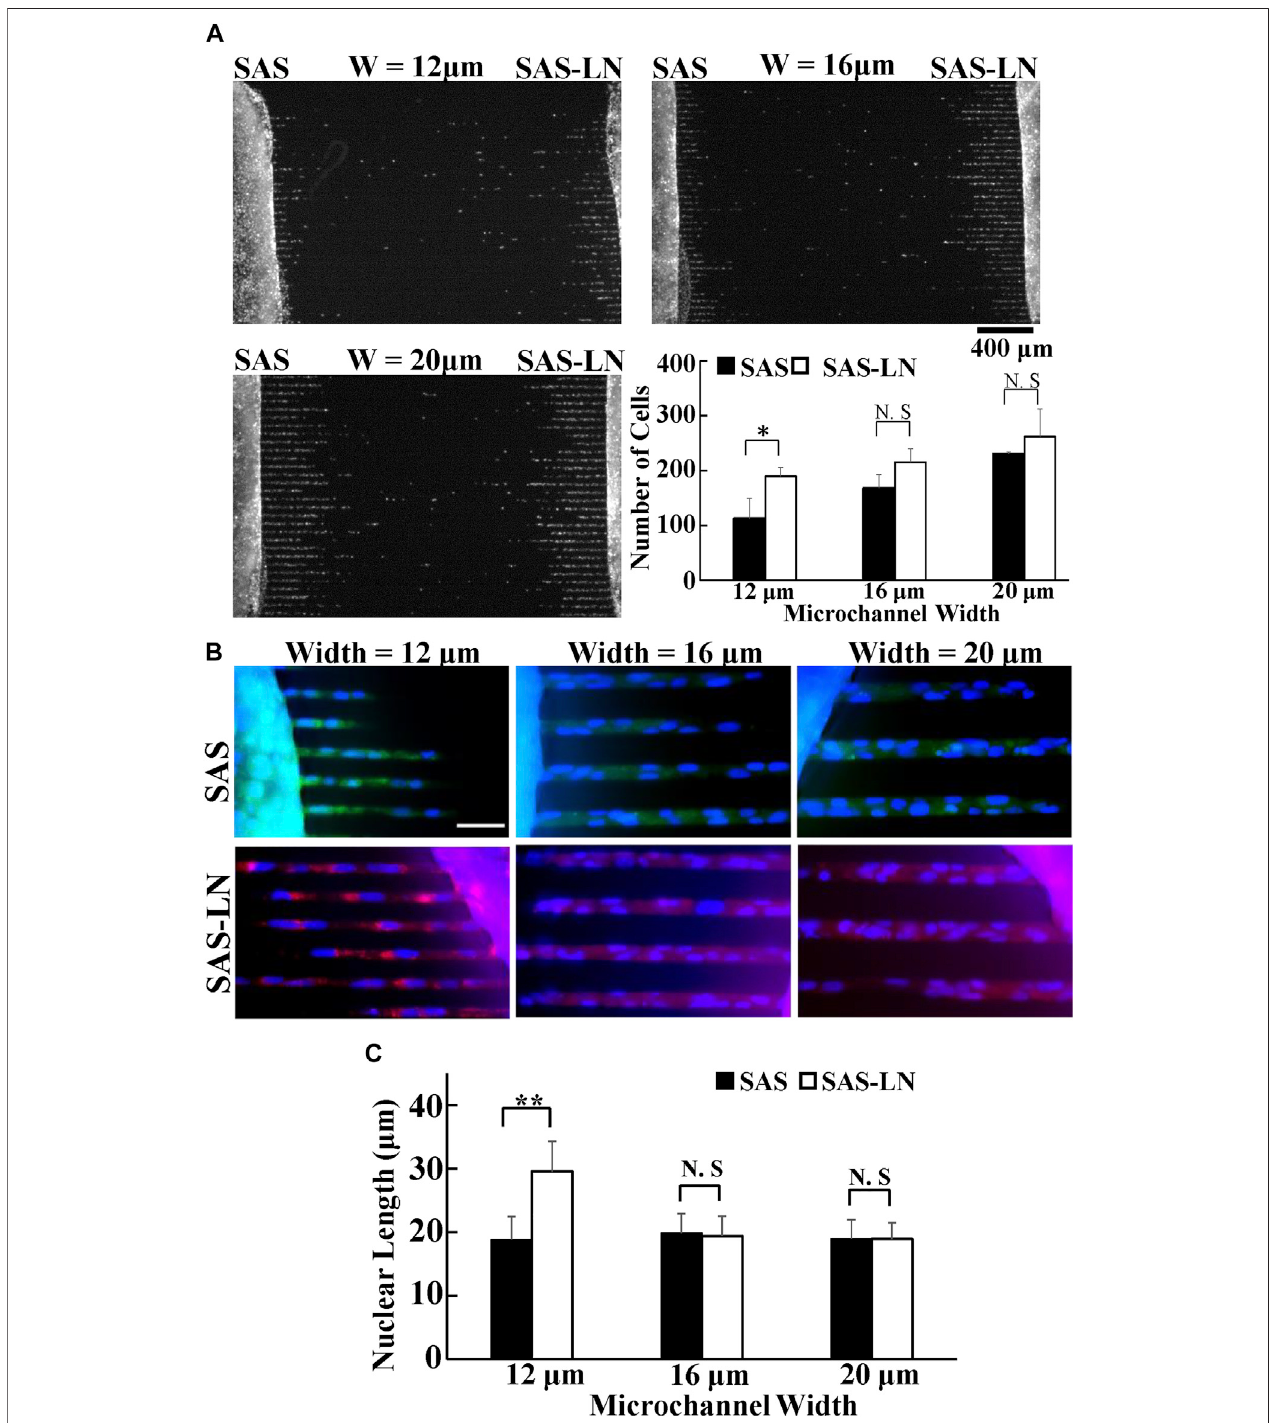
FIGURE 2 | Invasion capability of LN-metastatic HNSCC cells (SAS-LN) and non-metastatic HNSCC cells (SAS). (A) The numbers of SAS-LN and SAS cells, after invasionfor24 hfromtheaccessportsintothemicrochannels(withdifferentwidths).Tovisualizeandcountthenumberofcellsinthemicrochannels,thecellnucleiwere stained with Hoechst 33342. Data represent mean ± SD (n = 3). Scale bars=400 μ m. (B) The nuclear morphology of cells invasion into 12 μ m, 16 μ m, and 20 μ m channels.SAS-LNcellswerestainedwithcelltrackerRedCMTPXDye(showninred),SAScellswerestainedwithcelltrackerCMFDADye(showningreen),andcell nuclei were stained with Hoechst 33342 (shown in blue). Scale bars=50 μ m. (C) The nuclear length of SAS-LN and SAS cells, in 12, 16, and 20 μ m channels. Data represent mean ± SD (n = 50). *, for p < 0.05 and **, for p < 0.01; N.S: not signi fi cant.